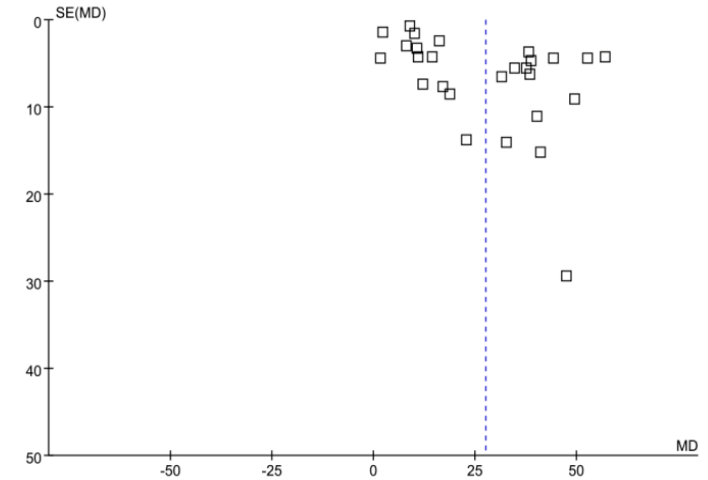
Figure 6. A funnel plot of the articles including the duration of hemodialysis.